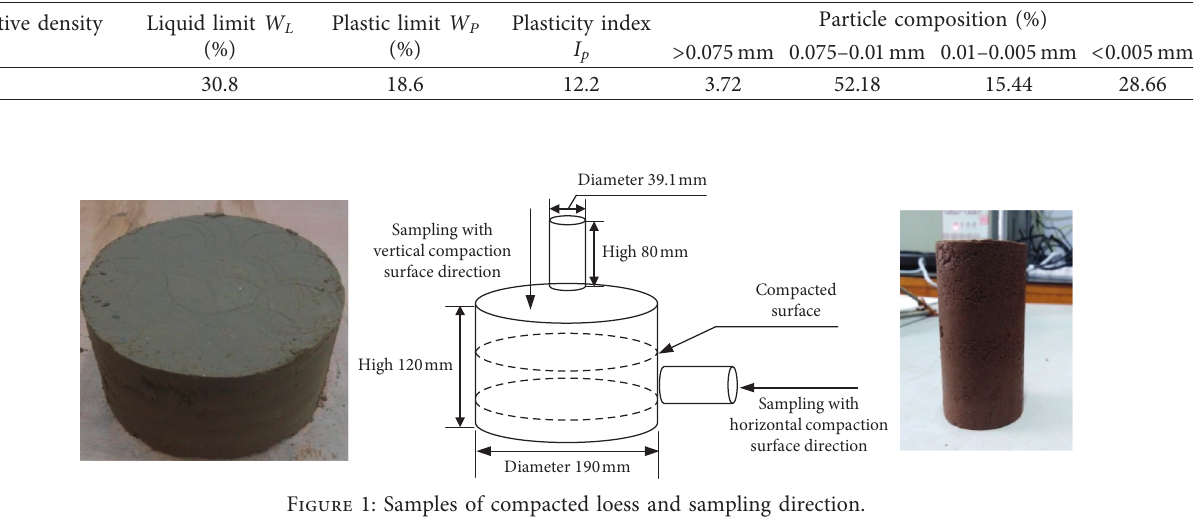
Table 1: Main indicator of the physical properties of